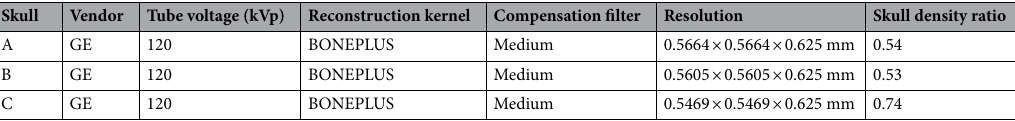
Table 2. CT parameters used for imaging the three ex vivo